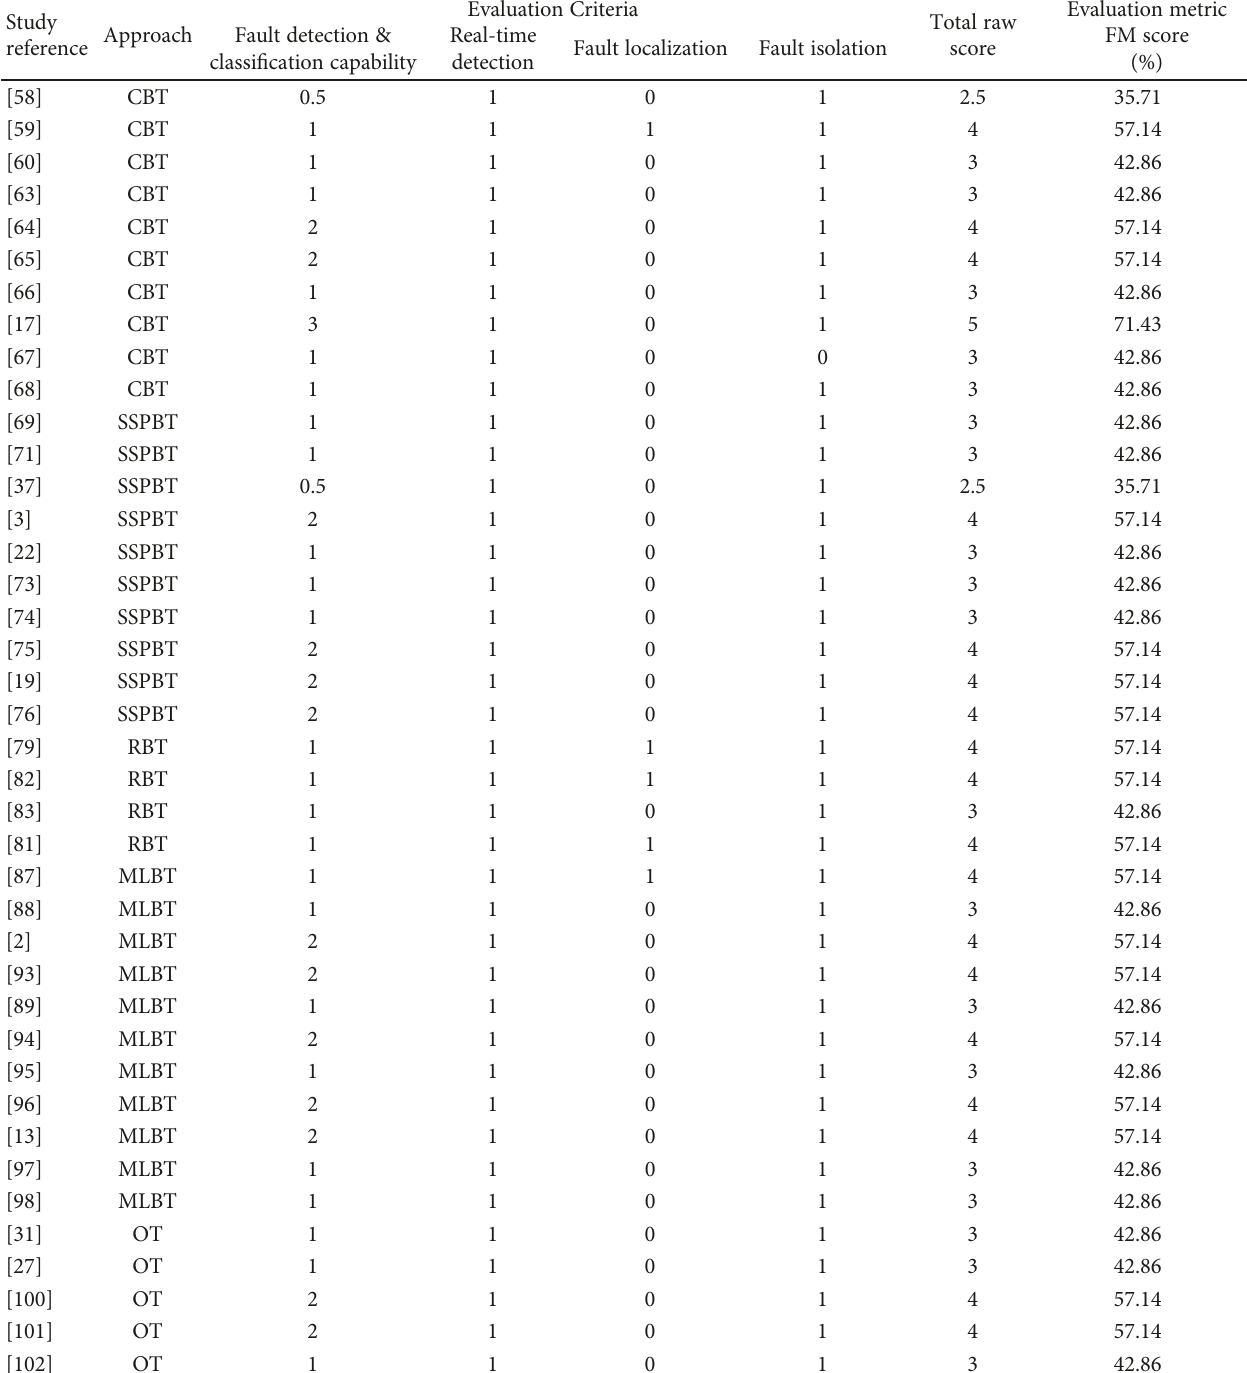
Table 1: Performance evaluation results for the FDD